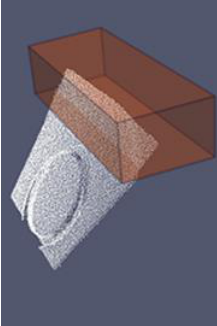
Figure 3. Selection of points corresponding to the lower plane of the examination table.